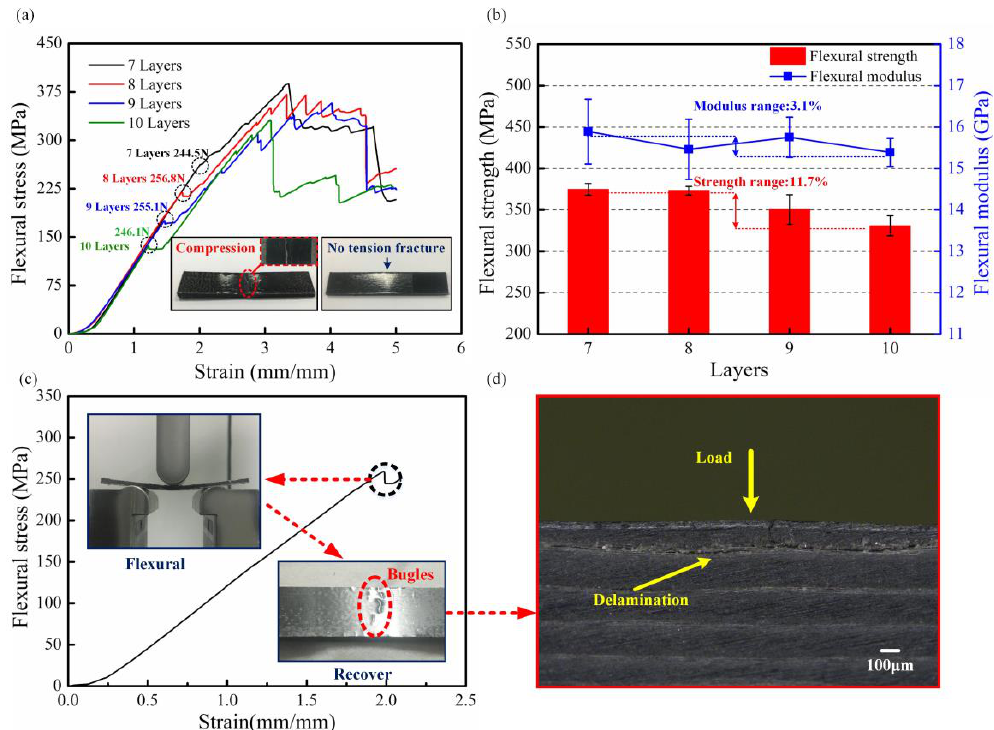
Figure 5. Flexural properties of multi-CFPL with different unit-CFPL numbers: ( a ) Stress-strain curves; ( b ) flexural strength bars and modulus curves; ( c , d ) are the testing curve and observation of the first failure point in the flexural stress curve done on the CFPL with a 7-layer unit-CFPL.